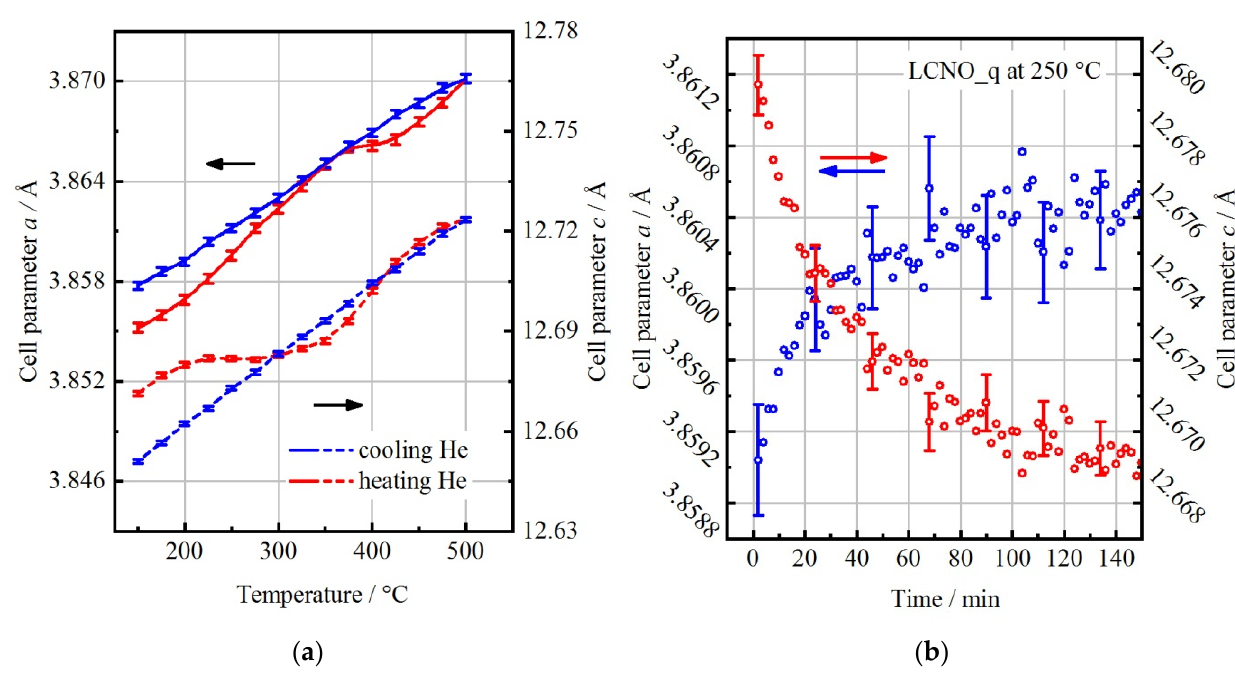
Figure 2. Lattice parameters a, c as a function of temperature—( a ), as a function of time at 250 °C—( b ) obtained from XRD patterns for LCNO_01_q in He flow.